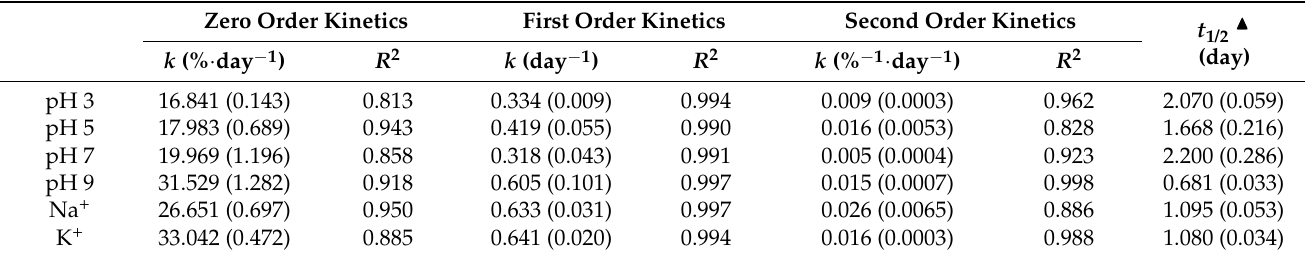
Data in the brackets were standard deviations ( n = 3); (cid:78) t 1/2 represent the half-life periods (day) in the first order kinetics. By comparing the t 1/2 , it could be seen that the retention rate of Asta at pH 3.0 (2.070 ± 0.059 day) or pH 7.0 (2.200 ± 0.286 day) was more than three times higher as com- pared to that at pH 9.0 (0.681 ± 0.033 day). Under extreme alkalis conditions, the